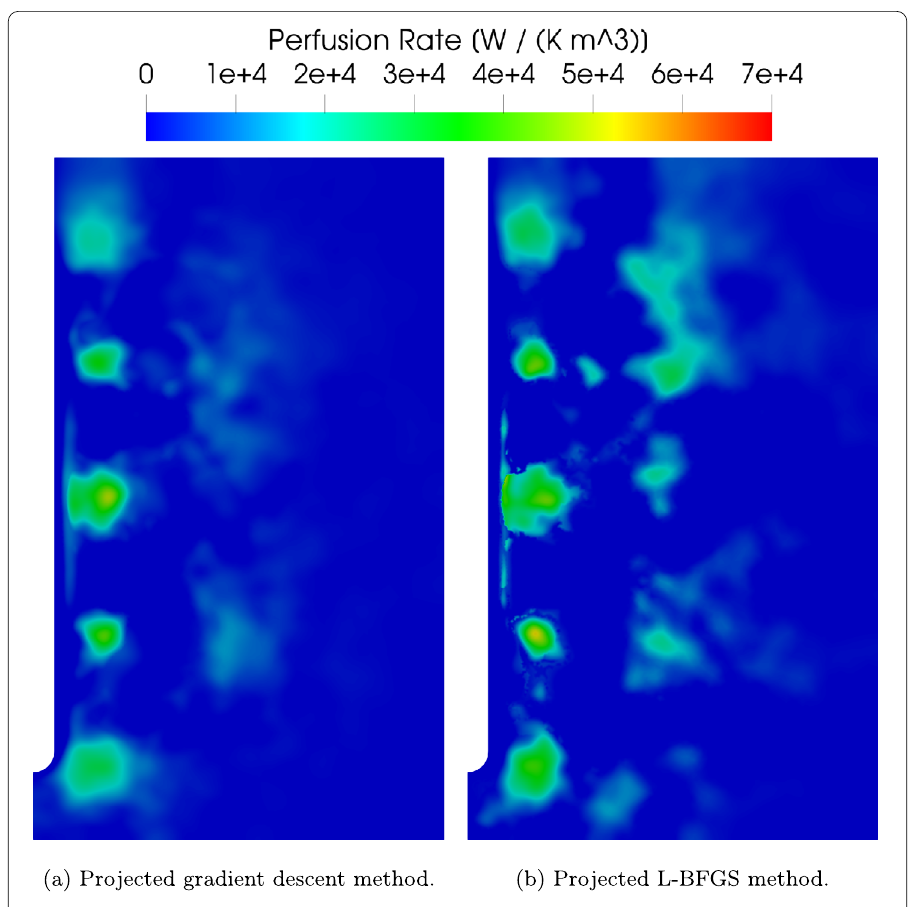
Figure 10 Identified perfusion rates for multiple noisy measurements